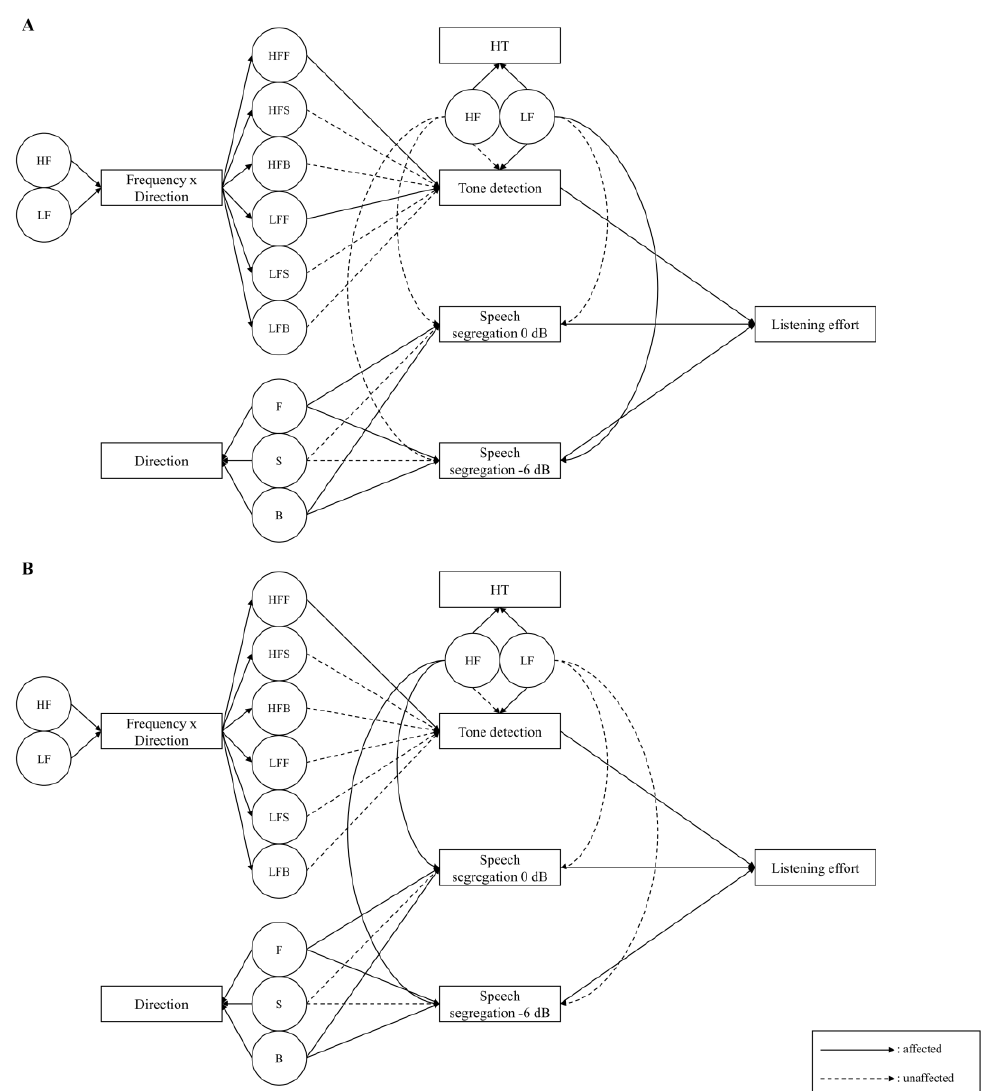
Figure 3. Multiple linear regression model of the older adults ( A ) and young adults ( B ). HF, high frequency; LF, low frequency; HFF, high frequency front; HFS, high frequency side; HFB, high frequency back; LFF, low frequency front; LFS, low frequency side; LFB, low frequency back; F, front; S, side; B, back; HT, hearing threshold.